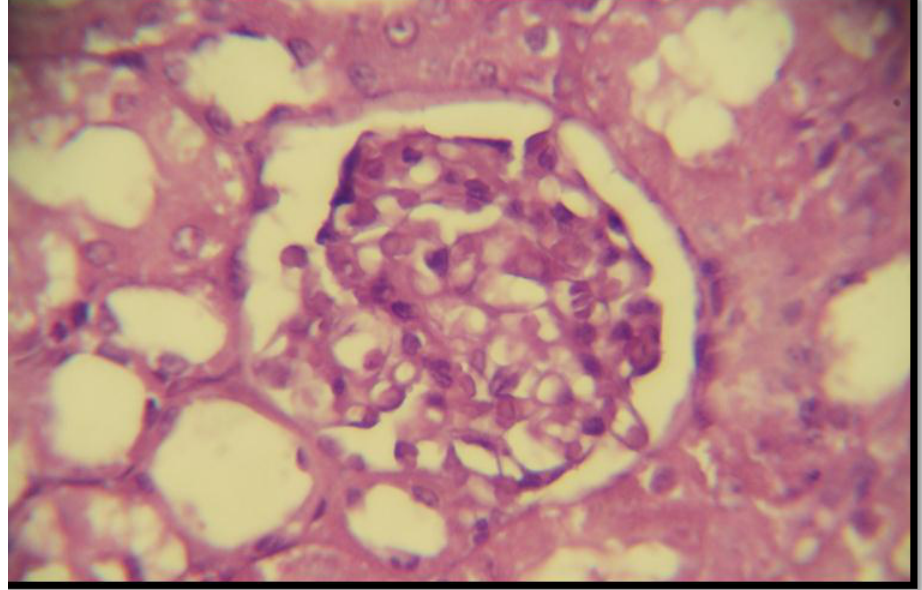
Figure (4): Histological section in normal animal showed normal structure of kidney (E&H Stain 40X)